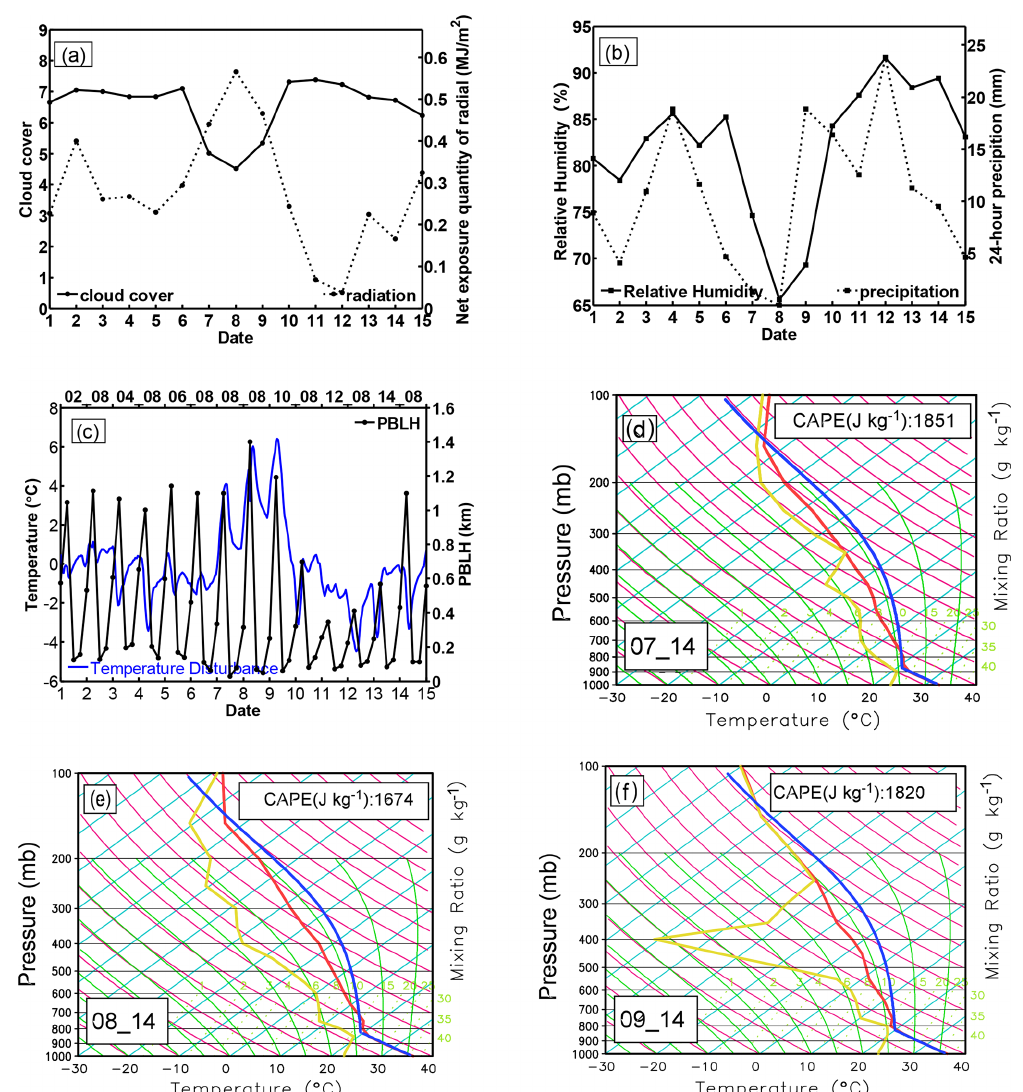
Figure 3. Time series of diurnal mean (a) cloud cover, radiation at 59287 observation station, (b) relative humidity, 24h precipitation, and averaged (c) planetary boundary layer height (PBLH) and temperature anomaly of region D0 from 1 to 15 July. The SkewT / LogP at 14:00 on 7 (d) , 8 (e) , and 9 July (f) . The solid thick red, blue, and yellow lines in (d, e , and f) denote the temperature sounding, the parcel path from the surface upward, and the dew point sounding,